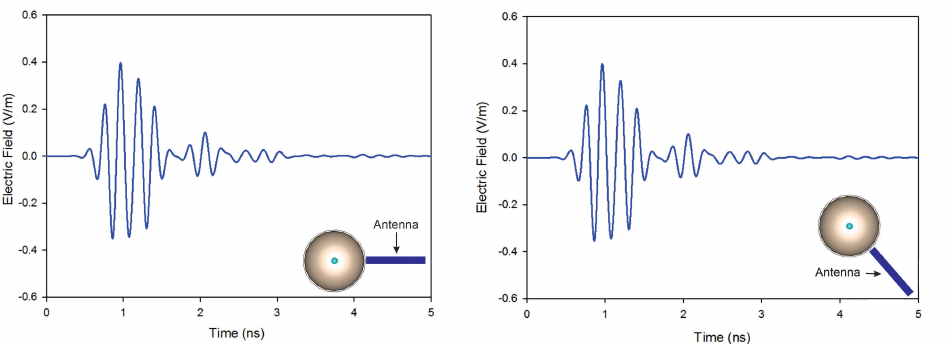
Figure 11. Back-scattered responses at two antenna positions using the conventional method.